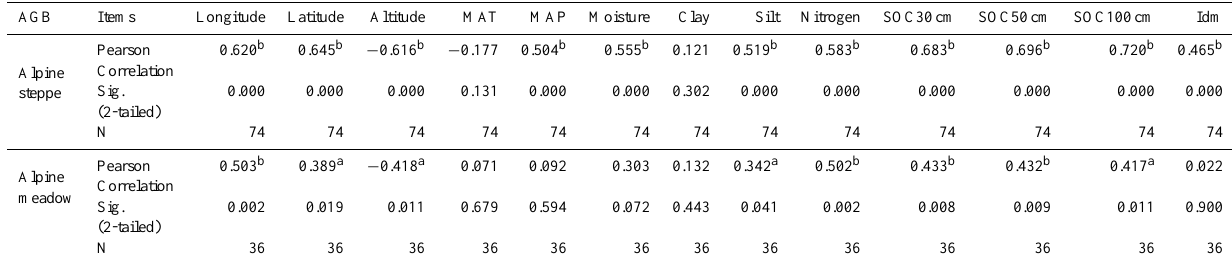
Table 2. Correlations between AGB and environmental factors.